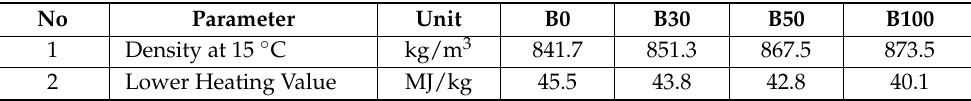
Table 2. Density and heating value for all tested